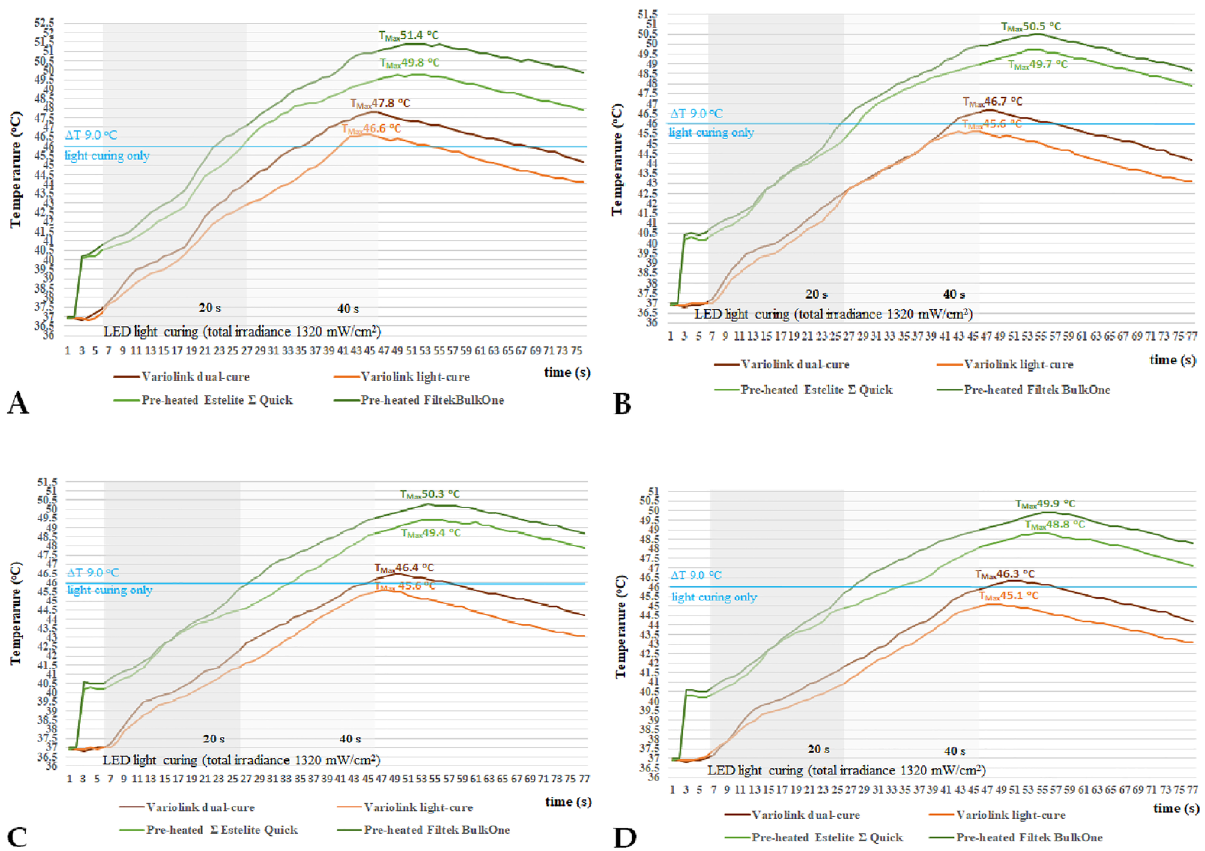
Figure 3. Representative registration curves of pulpal temperatures measured during irradiation of light-cured, dual-cured resin cements and pre-heated resin composites through 0.3 mm ( A ), 0.5 mm ( B ), 0.7 mm ( C ) and 1.0 mm ( D ) thick ceramic